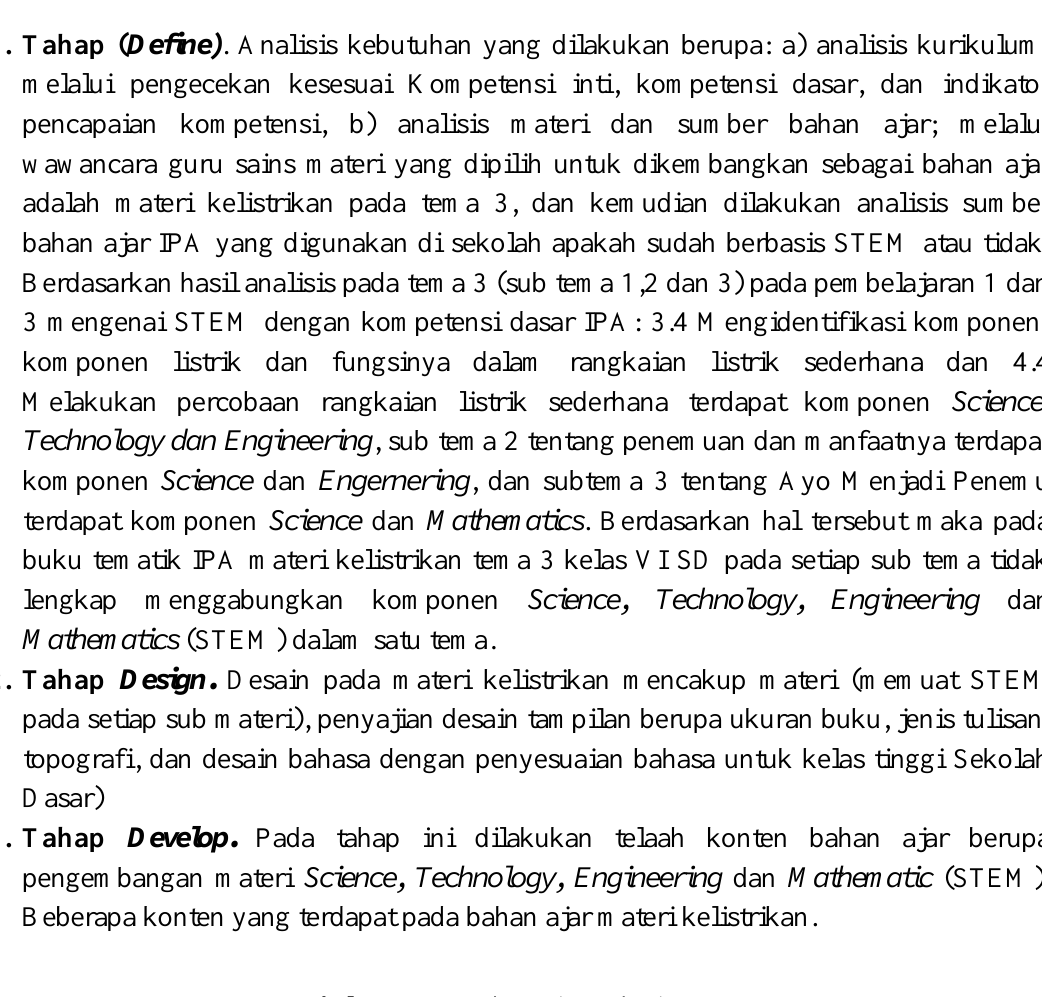
Tabel 4. Konten Bahan Ajar Berbasis